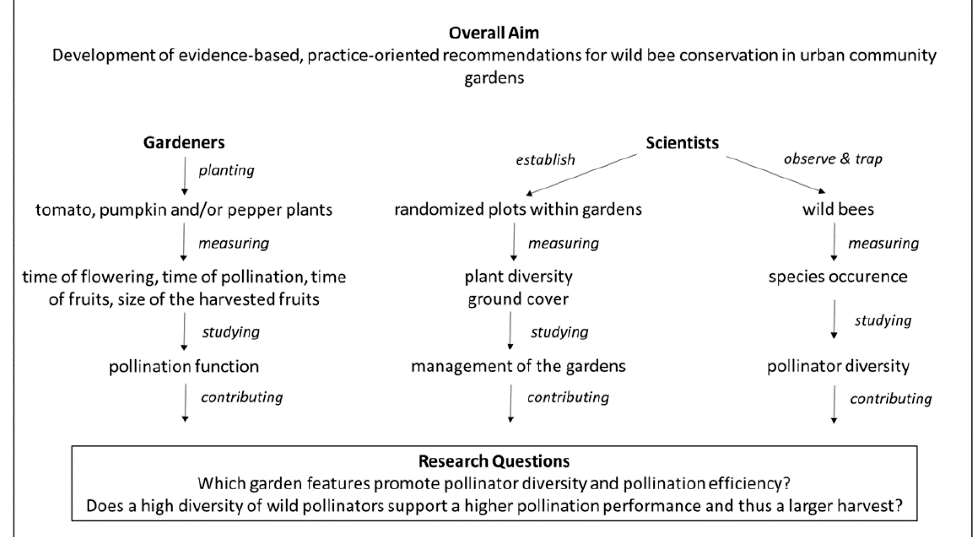
Figure 2. Overview of the ongoing pollinator CS project in community gardens in Berlin and Munich, Germany, detailing the collaboration of gardeners and scientists in urban ecology research for urban wild pollinator conservation. Table 1. Overview of studied variables and used measurements in the survey instrument.